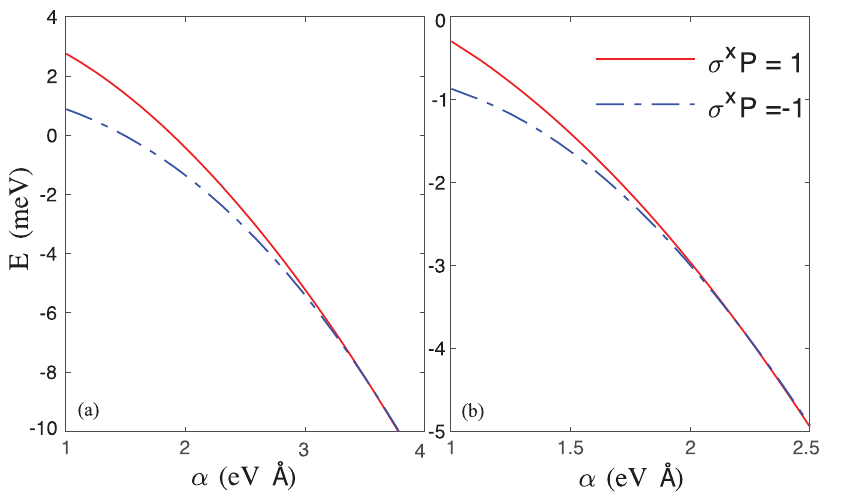
Figure 3. The lowest two energy levels as a function of the SOC strength α . ( a ) The results in the ISW. ( b ) The results in the